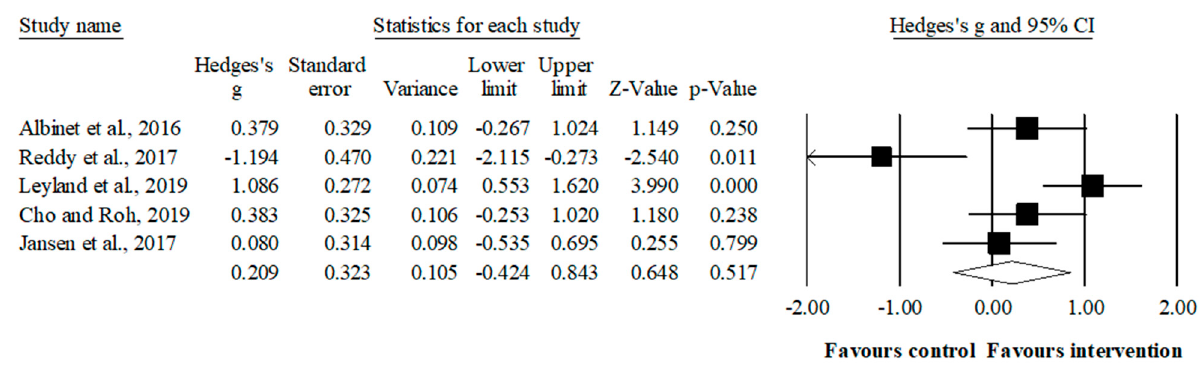
Figure 4. Forest plot of effects on cognitive flexibility. Values shown are effect sizes (Hedges’s g) with 95% confidence intervals. The size of the plotted squares reflects the statistical weight of the study [44,49–51,88]. 3.7. Adverse Effects None of the included studies reported soreness, pain, fatigue, injury, damage, or re- lated adverse effects resulting from the sports-based interventions. 4. Discussion In this meta-analysis, we analyzed the results of nine longitudinal studies that in- cluded at least one experimental group and one control group as well as pre- and postintervention measurements. The results of our systematic review showed that there